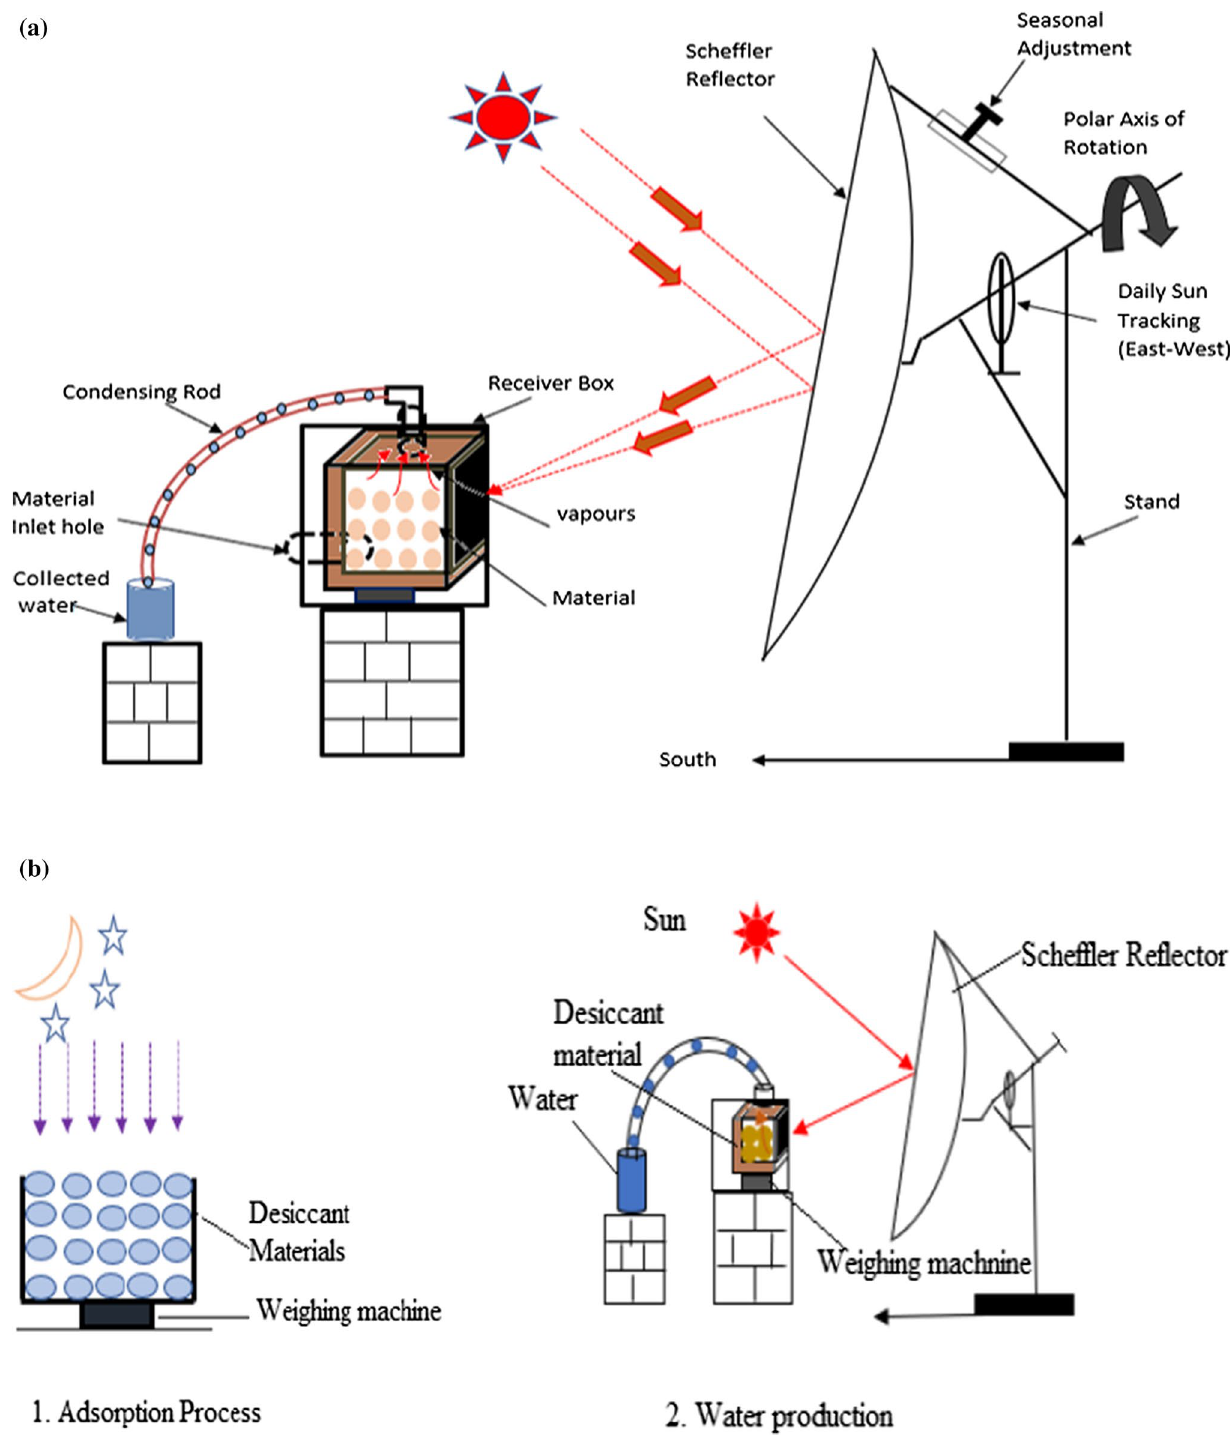
Fig. 1 a Schematic diagram of experimental setup and b Schematic diagram of process of water production from atmospheric air at night and day